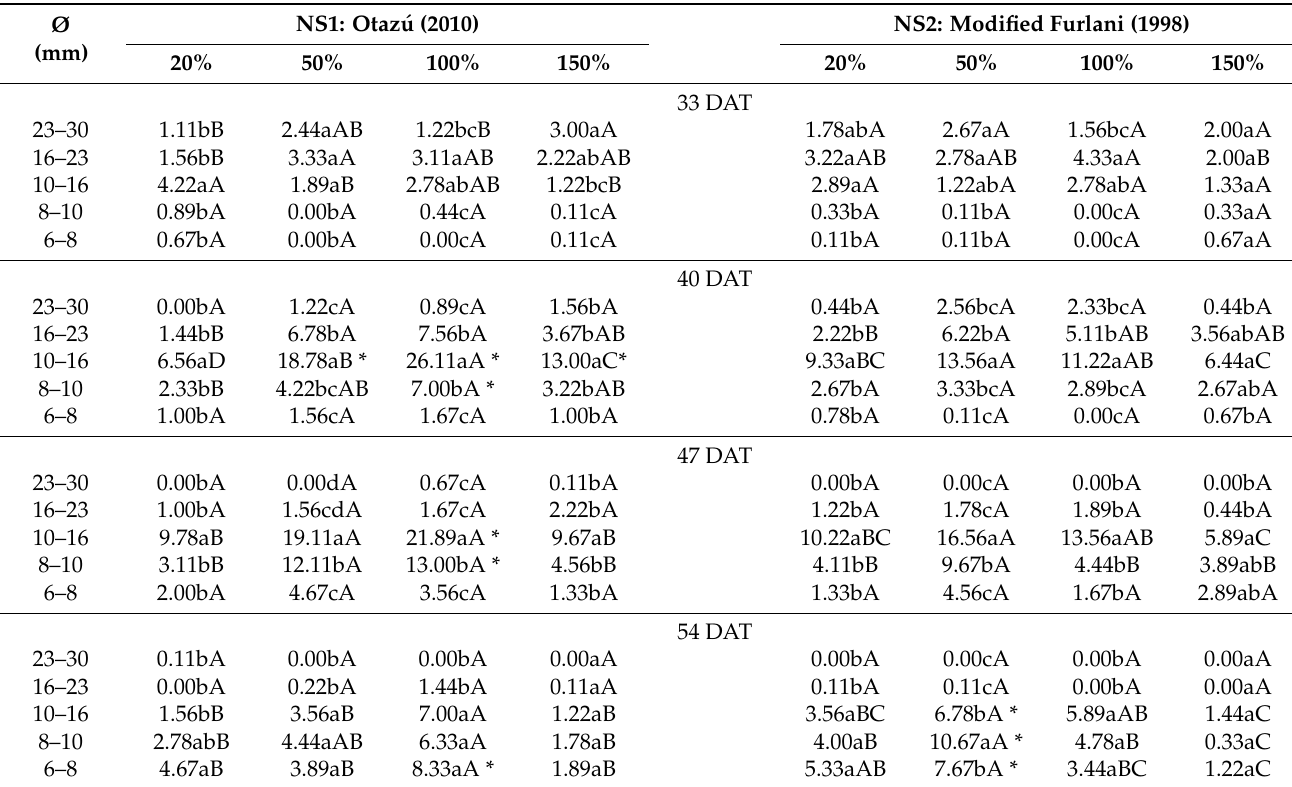
Table 7. Minituber numbers yield (tubers plant − 1 ) at 33, 40, 47, 54, 61 days after transplant (DAT), and total sum ( ∑ ) of minitubers for the respective combinations of cross diameter (Ø), nutrient solution, and N concentration in an aeroponic